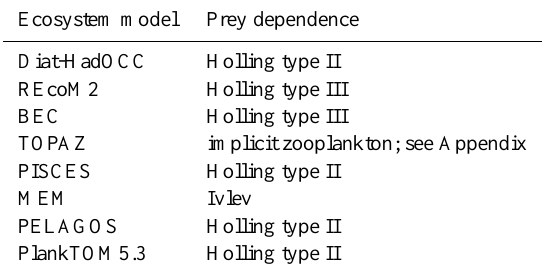
Table 5. Comparison of prey dependence of grazing. For the full equations, see the Appendix.